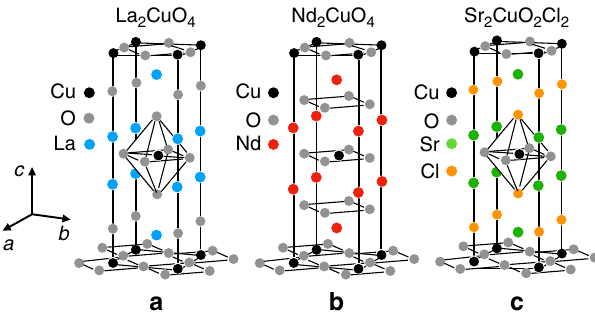
Fig. 1 Crystal structure of La 2 CuO 4 , Nd 2 CuO 4 , and Sr 2 CuO 2 Cl 2 . Sketch of the crystal structure of the three single-layer cuprate Mott insulators compared in the present study: a La 2 CuO 4 , b Nd 2 CuO 4 , and c Sr 2 CuO 2 Cl 2 . Note that the small orthorhombic distortion in La 2 CuO 4 below 530 K is not shown here, nor is the tilt in the oxygen octahedra surrounding the Cu